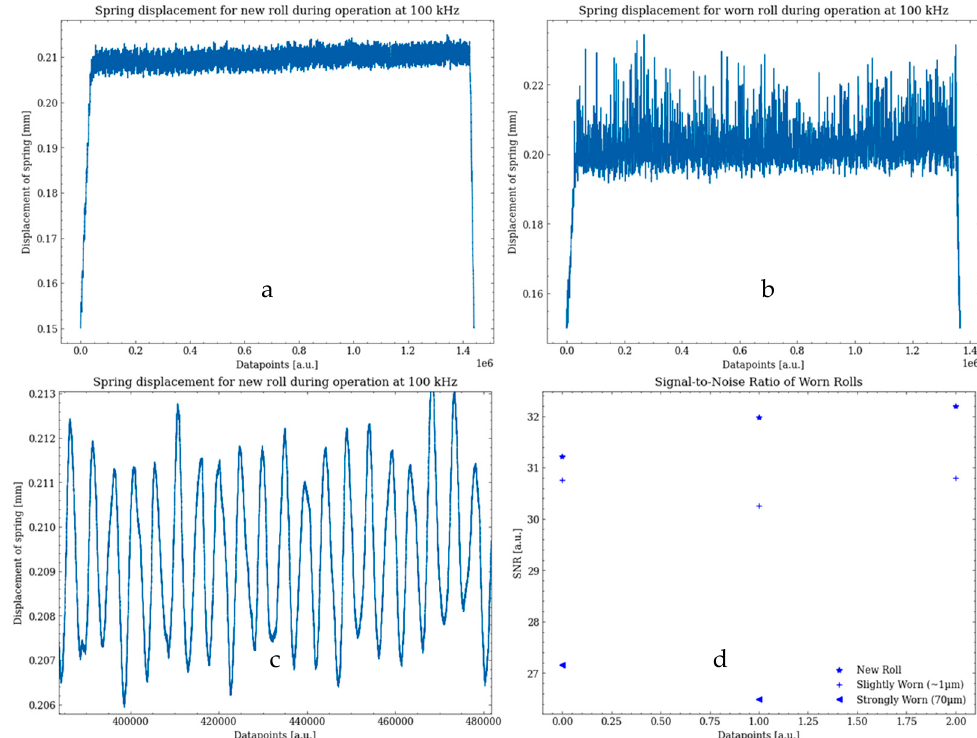
Figure 8. Spring displacements of the tool during roller burnishing operations. ( a ): Displacement signal of a new roll. ( b ): Displacement signal of a strongly worn roll. ( c ): Zoom of the displacement signal of a new roll. The signal shows the roundness deviation of the workpiece with an approximate amplitude of 5 µm. ( d ): Signal-to-noise ratios of the displacement signal from rolls in three different wear states. Stars: New roll. Cross: Roll with slight wear marks of approximately 1 µm in size. Triangle: Worn roll with strong wear marks of approximately 70 µ m in size. Source: